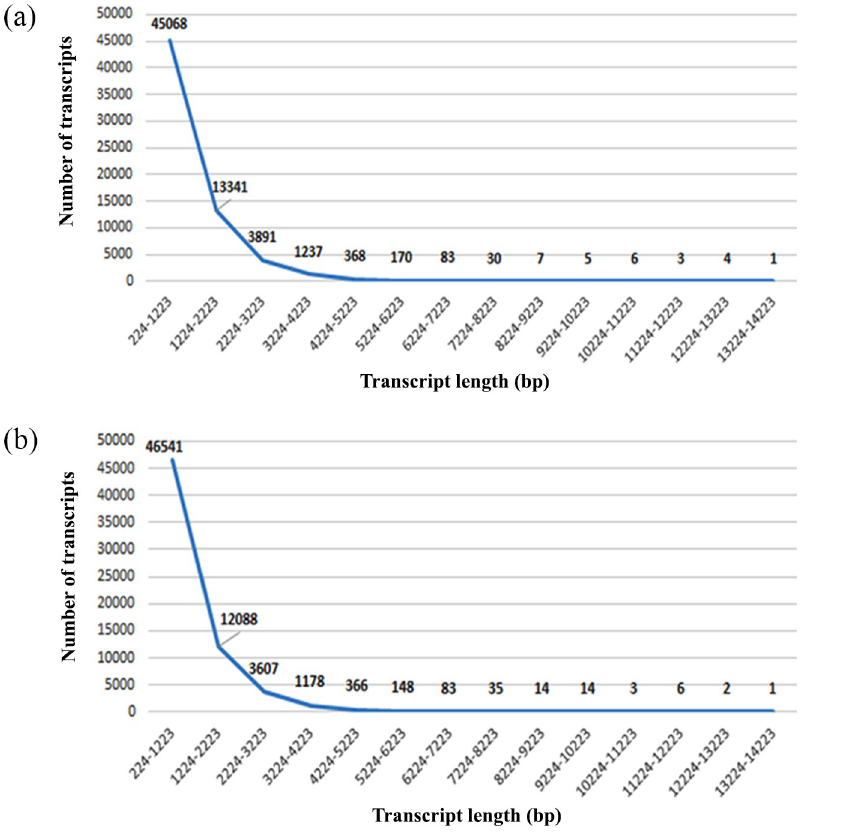
Fig 2. Transcript length distribution analysis of (a) C . cajan and (b) C . platycarpus